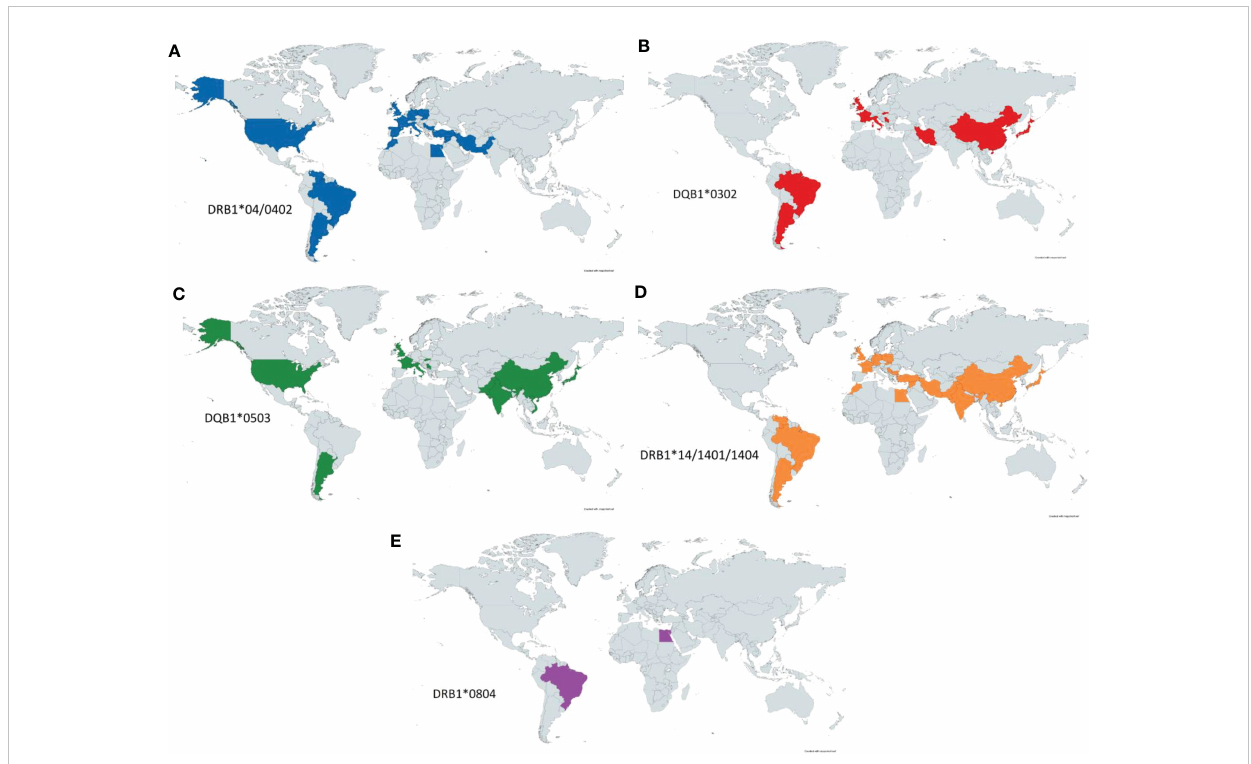
FIGURE 5 PV-HLA Associations Reported by Country. Known HLA associated alleles as reported by country. Signi fi cant overlap is seen between DRB1*0402 (A) and DQB1*0302 (B) as these alleles have previously been shown to be in linkage disequilibrium. DQB1*0503 (C) is seen throughout the world but is notably concentrated in eastern and southern Asia. DRB1*14 (D) is seen diffusely throughout the eastern hemisphere as well as South America. Lastly, DRB1*0804 (E) has been more rarely reported in PV but has been noted in Egypt and Brazil.